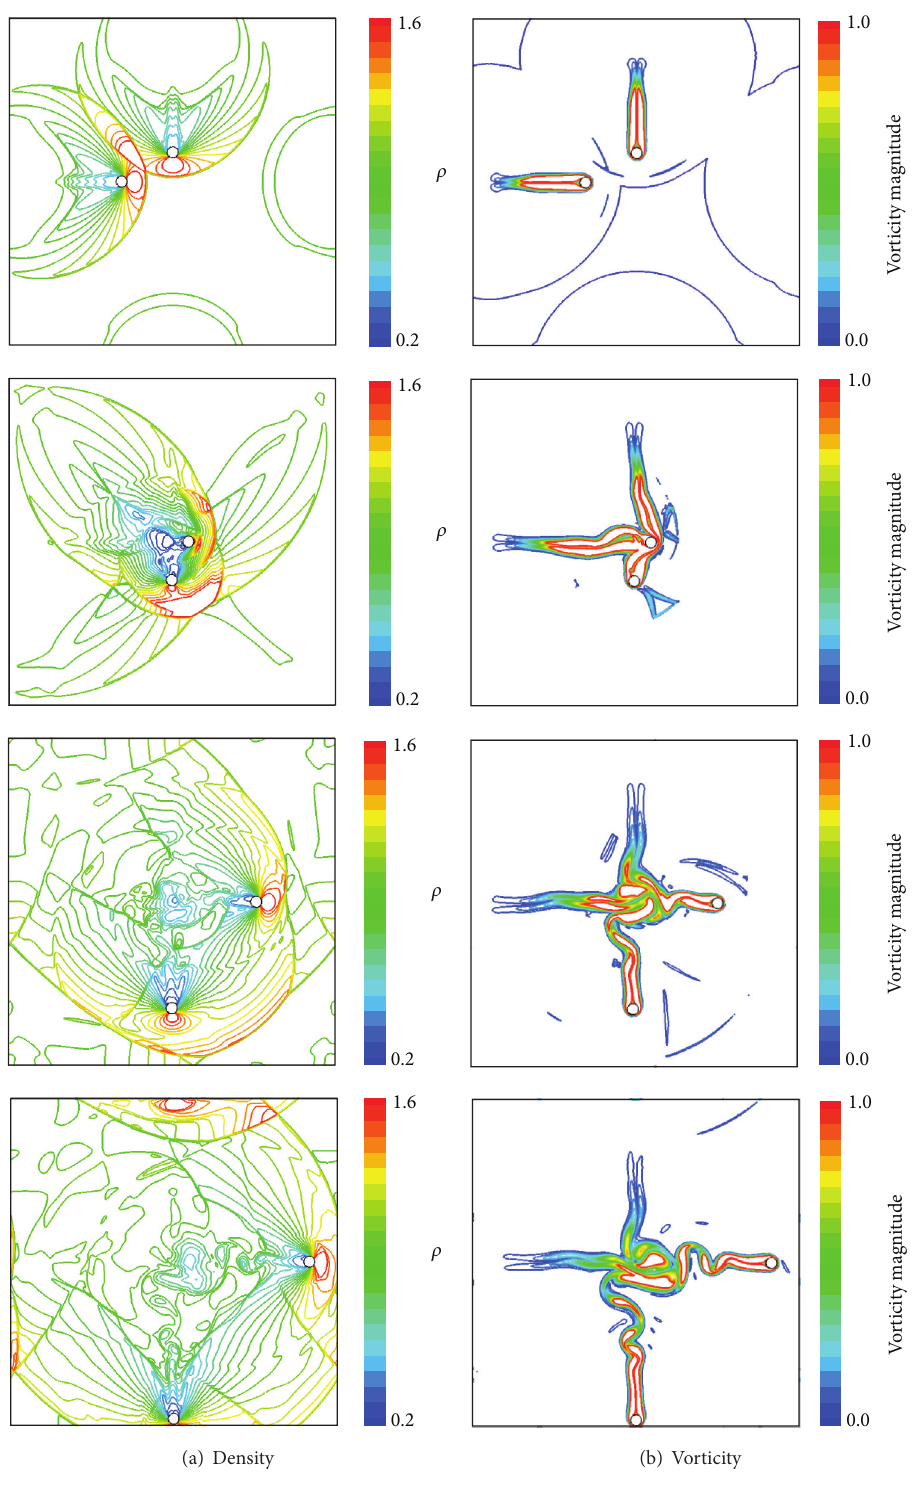
Figure 23: Density and vorticity contours around two crossing cylinders at nondimensional times = 7.8, 12.9, 18.1, and 22.0 with 𝑑𝑥 = 0.025 𝐷